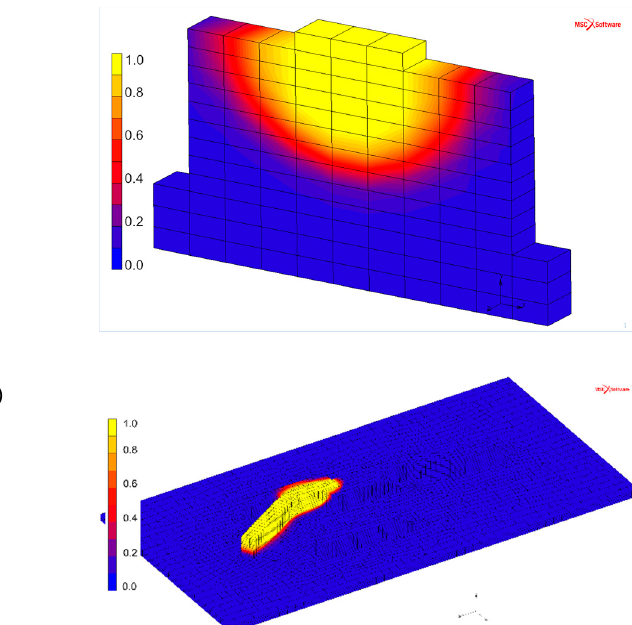
Figure 11. Simulated β phase fraction during wire feed additive manufacturing. ( a ) Cross-section of the three-weld beads wall. ( b ) Complete view of the sample.